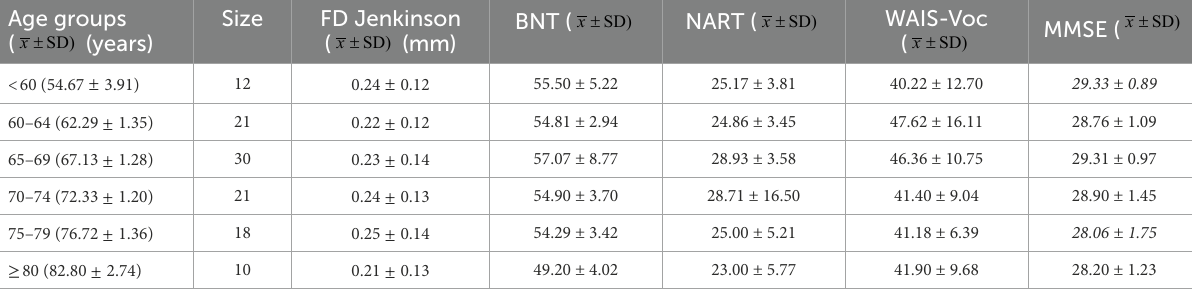
TABLE 1 Description of movement and neuropsychological measures between age groups. Age groups (